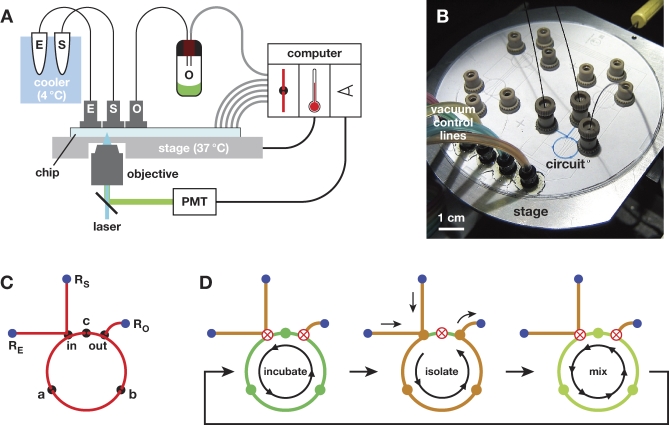
Microfluidic Evolution System(A) The evolution chip is mounted on a temperature-controlled stage. Solutions containing polymerase enzymes (E) and mono- and oligonucleotide components (S) are delivered to the chip via capillary tubing and output to a pressure-controlled collection vial (O). A microscope objective is used to focus laser excitation (λex = 490 nm) on the microfluidic channel and to gather fluorescence (λem = 535 nm), which is detected with a confocal PMT. Valve actuation and fluid flow are controlled by six independent vacuum lines.(B) The microfluidic device is shown with the active circuit filled with blue dye.(C) The serial dilution circuit consists of a mixing loop with fluid flow channels (red), fluid access reservoirs (blue), and control valves (black). Fluid flow around the loop is controlled by three two-way valves (a, b, and c). Fluid access to the loop from the input reservoirs (RE and RS) and to the output reservoir (RO) is controlled by bus valves (in and out). The bus valves allow access when open, and prevent access while preserving fluidic continuity within the loop when closed.(D) During operation of the circuit, the expanding RNA population is incubated while undergoing slow cyclic mixing until the fluorescence reaches a pre-determined threshold. Then an aliquot of the population is isolated between valves in and out as fresh solutions of E and S are drawn into the loop and spent materials are delivered to the collection vial. Finally, the loop is sealed by closing valves in and out, and the aliquot is mixed with the fresh solutions by rapid serial actuation of valves a, b, and c. Open valves are indicated by filled circles; closed valves are indicated by a red X.